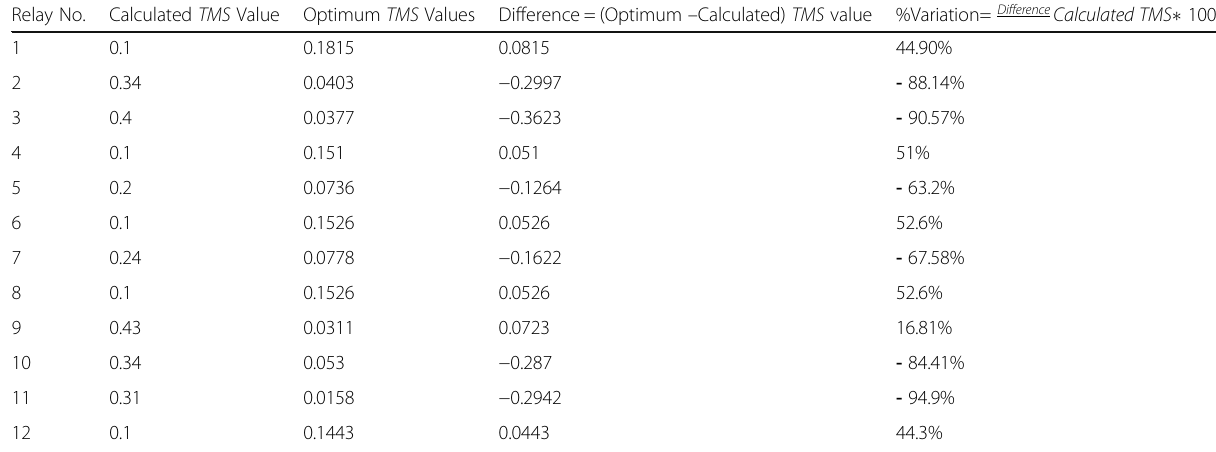
Table 3 Calculated and Optimum TMS